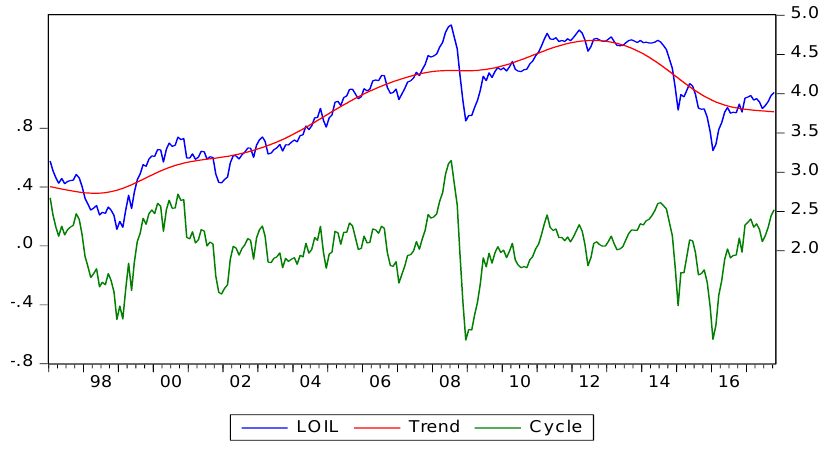
Figure 4: Hodrick-Prescott filtering of the logarithm of oil prices, 1997-2017